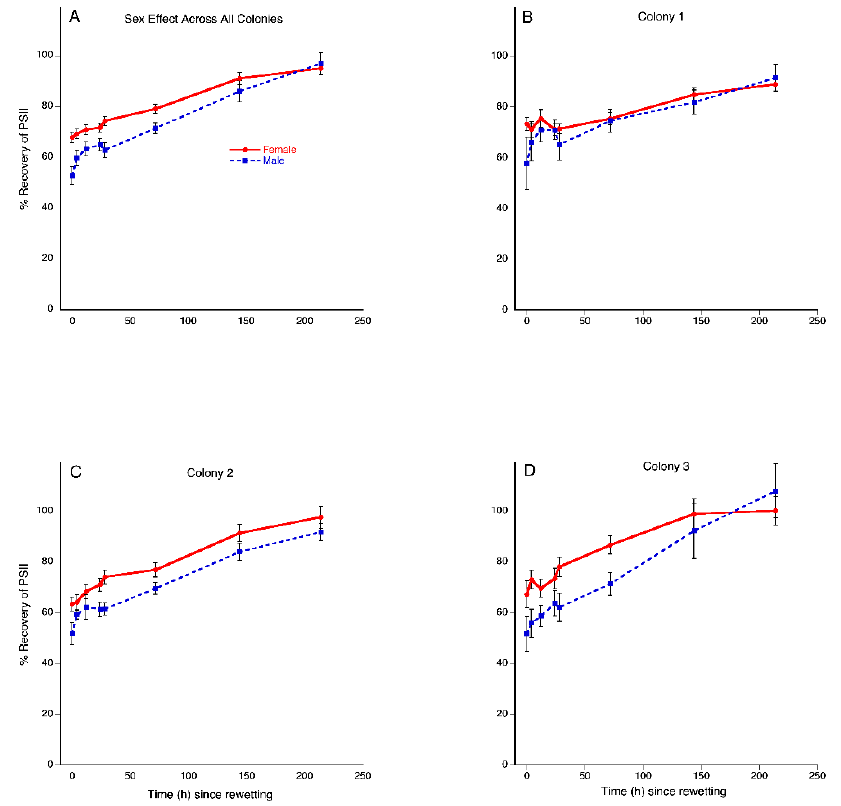
Figure 3. Desiccation tolerance in Plagiochila porelloides differs by sex and varies across colonies . Percent recovery of photosystem II assayed by chlorophyll fluorescence over 216 h after the drying event. ( A ) Overall sex difference in recovery for all three colonies combined; ( B , C ) Colony 1 and 2 respectively, showed no sex differences in recovery, although colony 2 was approaching a tendency of females having higher recovery ( p = 0.1113). ( D ) Colony 3 showed higher recovery in females relative to males. Data are untransformed percent recovery. The bars indicate standard errors.